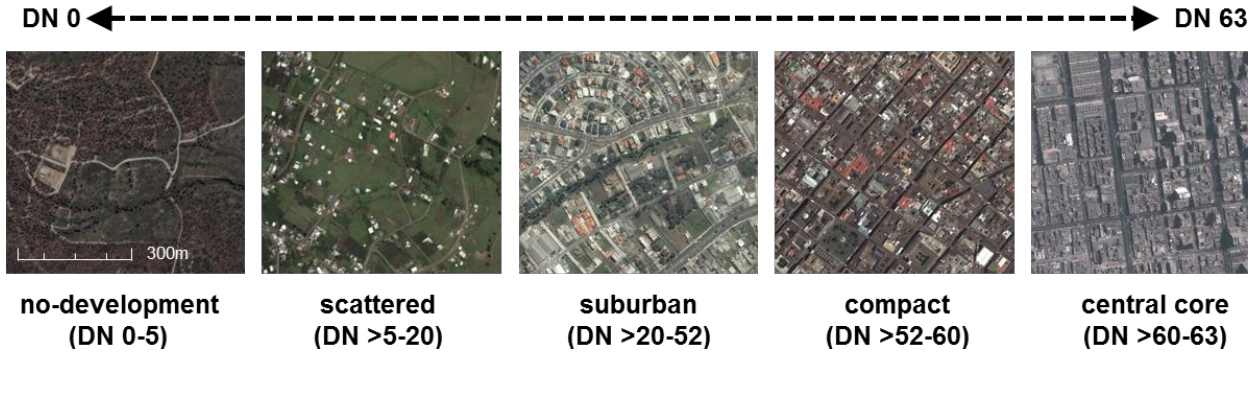
Figure 2. Google Earth images showing samples of the different land-use classes and their corresponding night-time lights Digital Value (DN) ranges. Sites: Lima, Perú and Santa Cruz,